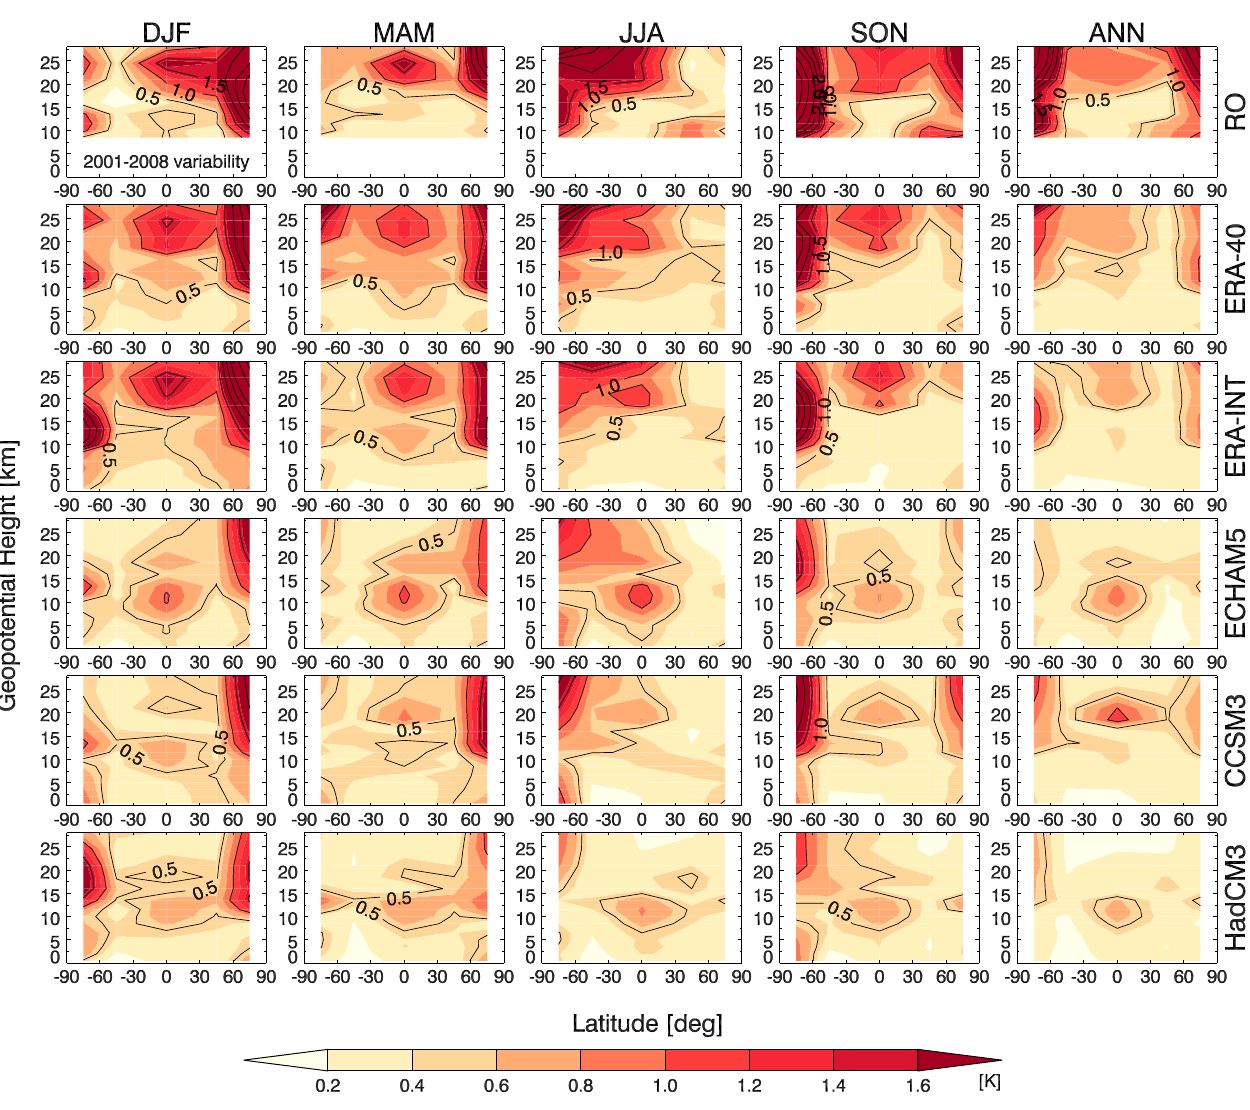
Fig. 4. Seasonal (columns DJF, MAM, JJA, SON) and annual (ANN) temperature variability (standard deviation of centered time series from which the linear trend was removed) for, from top row to bottom row, RO data (CHAMP record: September 2001 to September 2008), ERA-40 (1980 to 2001), ERA-INT (1989 to 2005), and one representative run of each of the three GCMs, ECHAM5, CCSM3, HadCM3 (1980 to